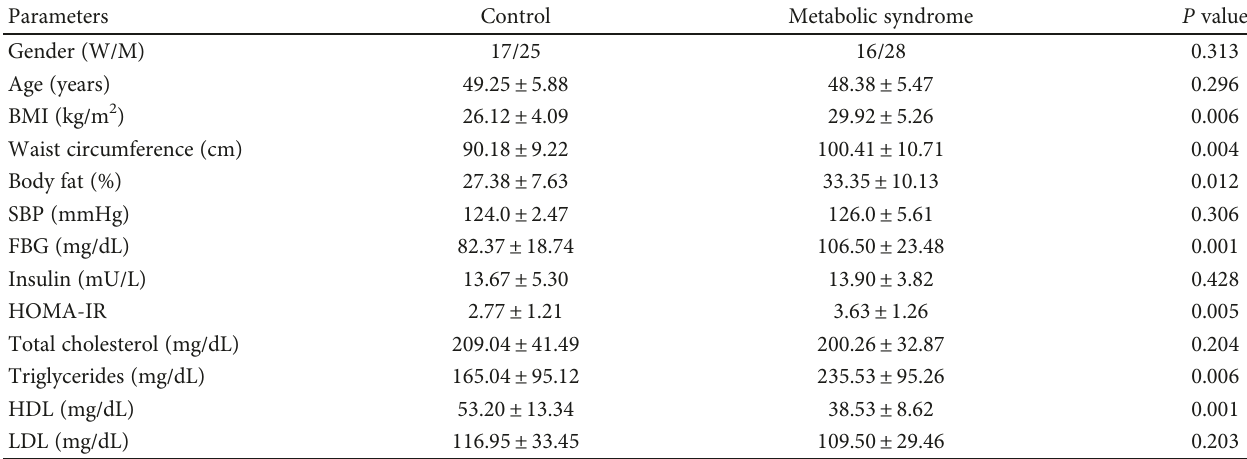
Table 1: Demographical and metabolic parameters of the study